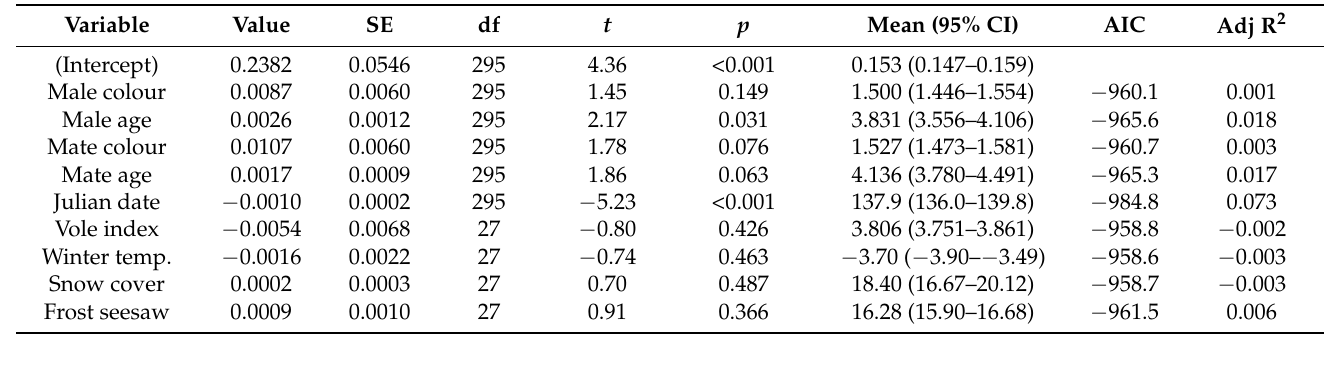
Table 4. Relationships between some intrinsic and extrinsic factors and the body condition of male Tawny Owls Strix aluco near the southern coast of Finland: generalised linear model (glm). The parameter estimates of data (mean and 95% confidence interval) are given.